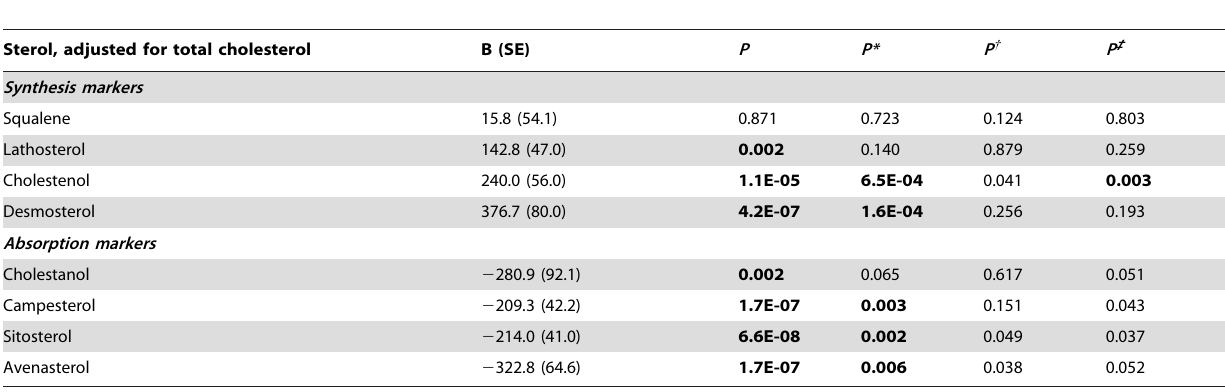
Table 3. Association between baseline sterol levels and glucose area under the curve (AUC) at the 5-year follow-up study.